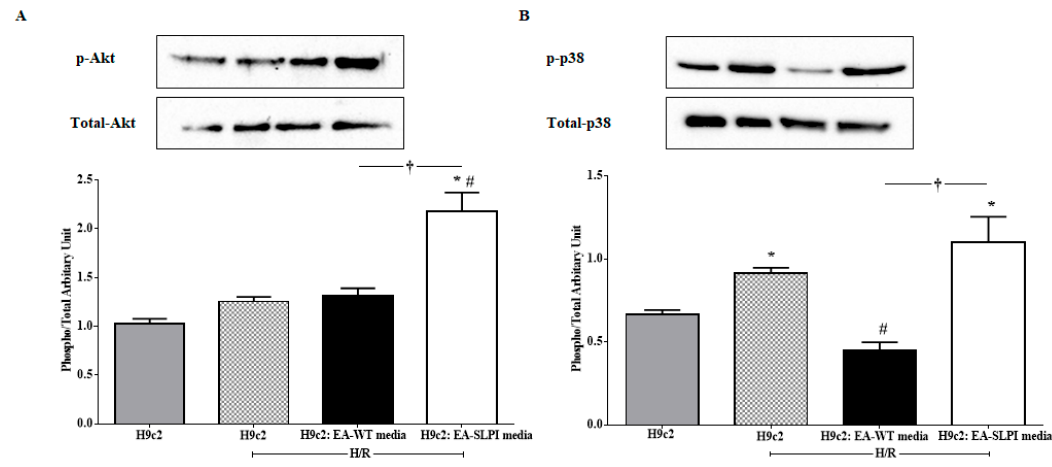
Figure 7. Determination of the e ff ect of rhSLPI secreted from endothelial cells on the cardiomyocyte cell line subjected to H / R in terms of the cellular signaling response. The media from cultured wild-type (EA-WT) and SLPI-overexpressing (EA-SLPI) EA.hy926 cells were transferred to culture H9c2